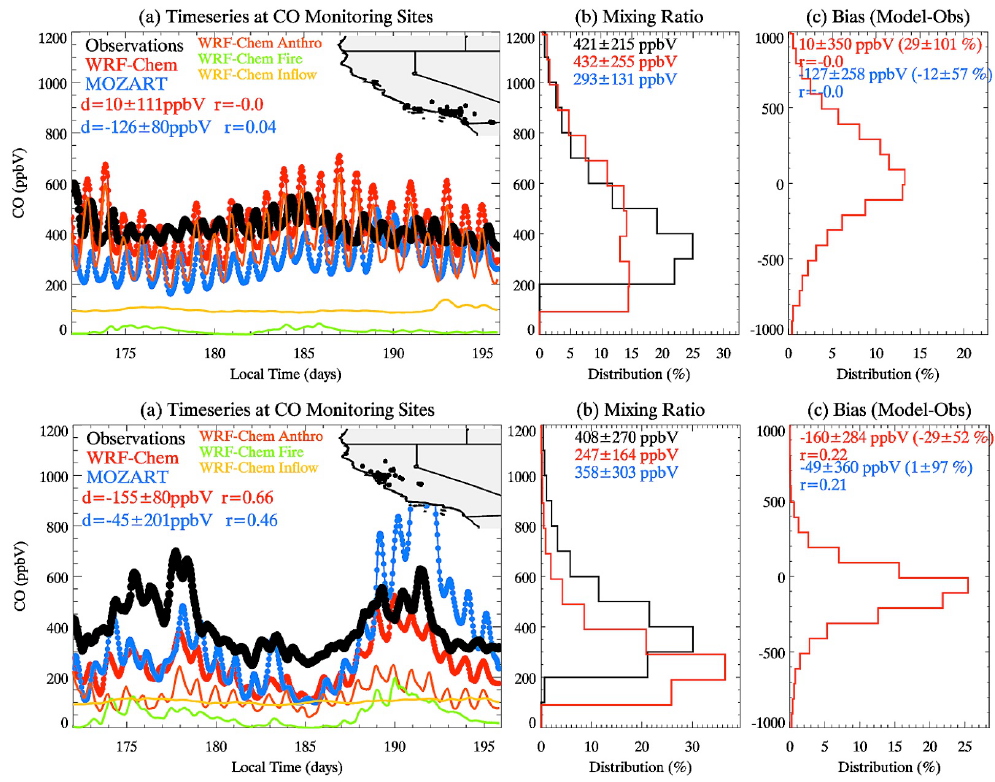
Fig. 5. Average time series (a) and hourly statistics ( b and c ) for observed (black) and modeled (WRF-Chem in red and MOZART-4 in blue) surface CO at monitoring sites. Upper graph: sites in Southern CA (latitudes < 36.5 ◦ N). Lower graph: sites in Northern CA (latitudes > 36.5 ◦ N). WRF-Chem mixing ratios for CO tracers for fire (green), anthropogenic (red), and inflow (orange) are included. Time series (a) are derived by averaging hourly mixing ratios over a moving 8-h window and over all sites. The mean bias d and correlation r between observed and modeled time series and hourly values for 20 June–15 July is stated in the